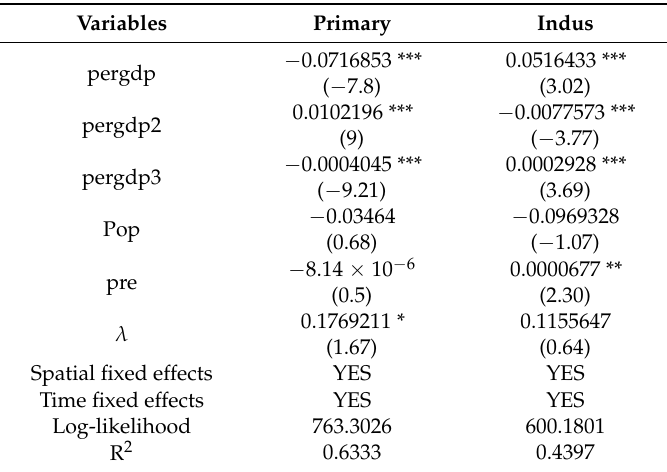
Table 8. Impact of the economy on the